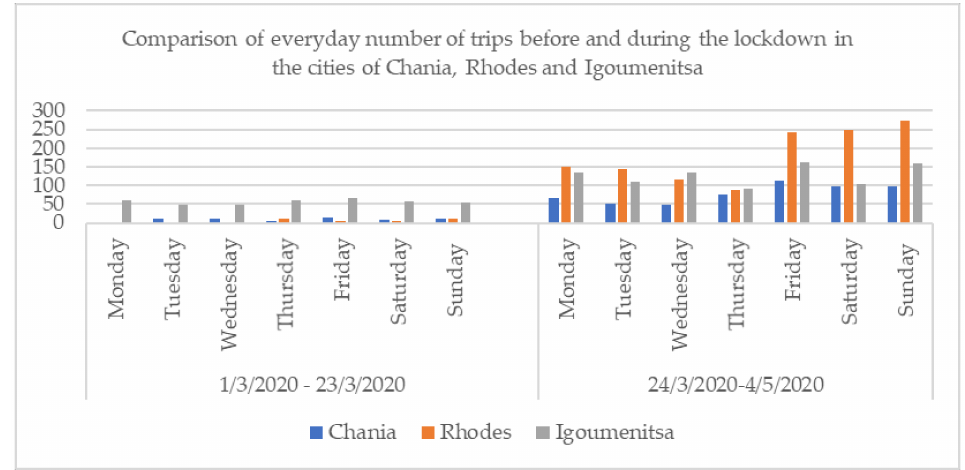
Figure 5. Comparison of summarized (total) number of rides per day before and during the lockdown in the cities of Chania, Rhodes, and